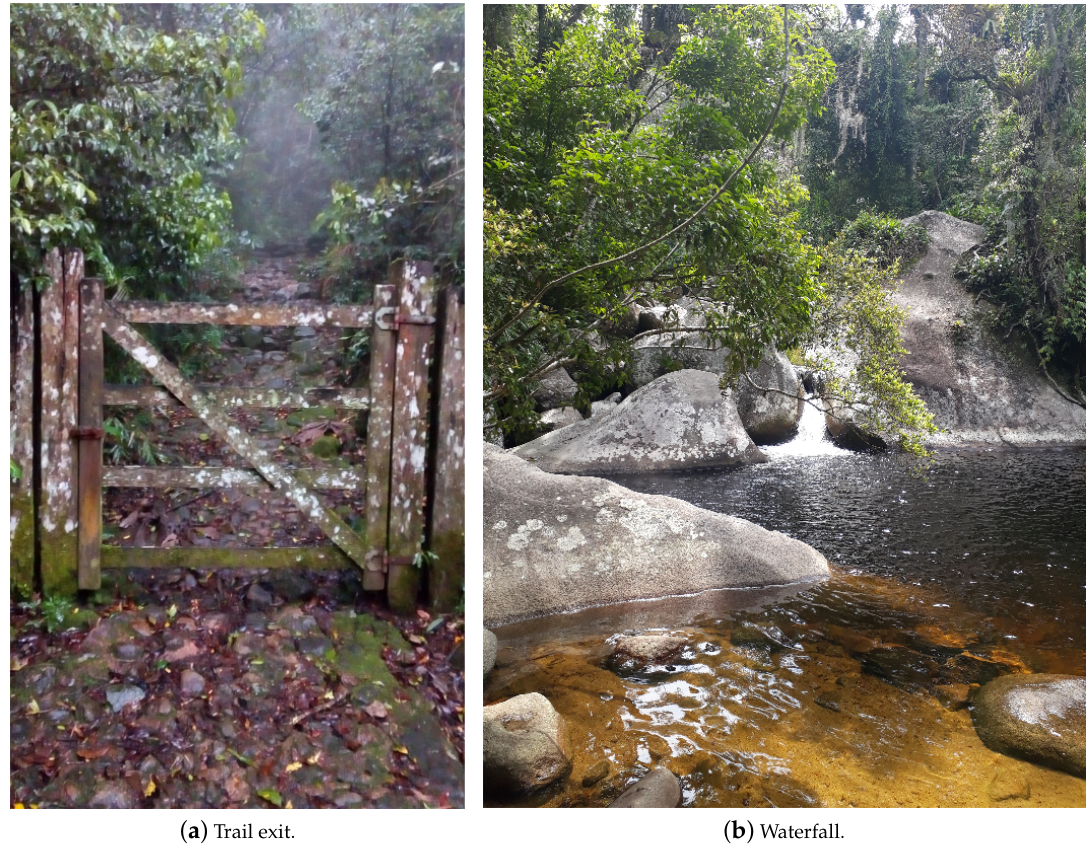
Figure 15. Locations for installing totems.